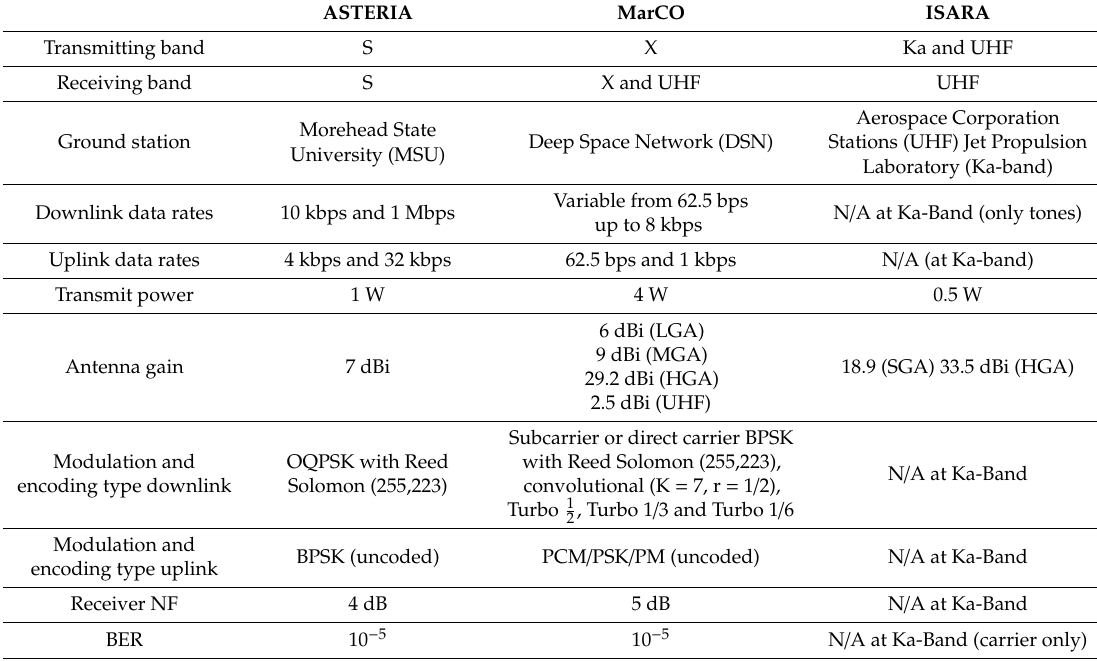
Table 4. Comparison of telecommunication parameters across the three